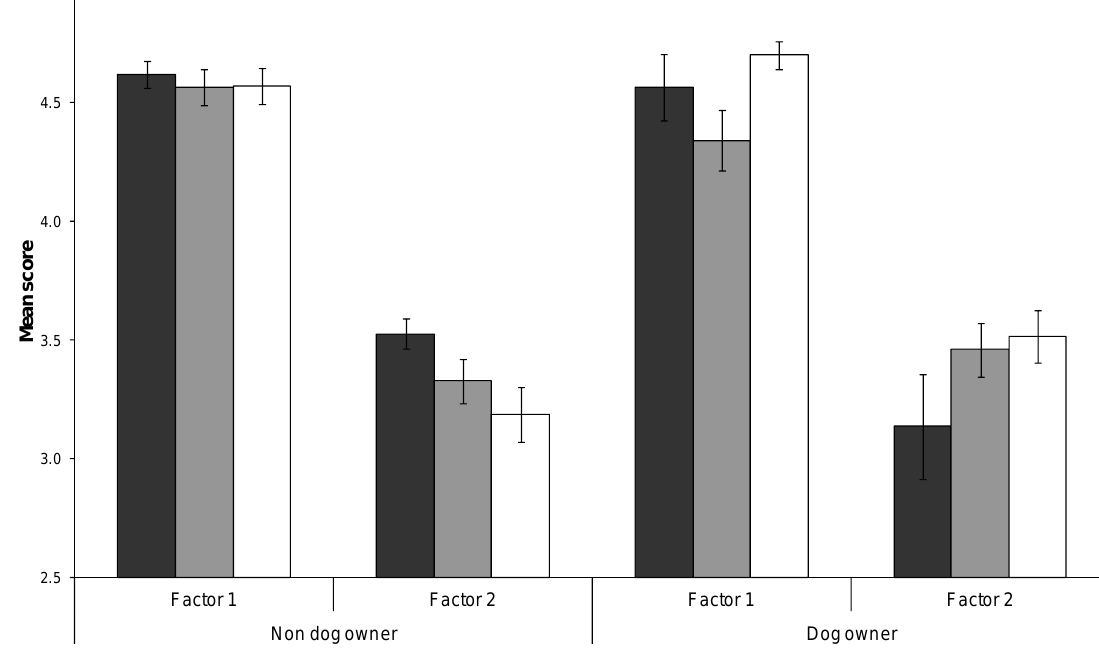
Figure 3. Mean scores (± one standard error) for factors related to ecosystem benefits of conservation (Factor 1) and single species benefits of conservation (Factor 2) in relation to respondents beach use (black bars represent yearly, grey bars monthly, and white bars weekly) and dog walking on beaches (dog owners, non-dog